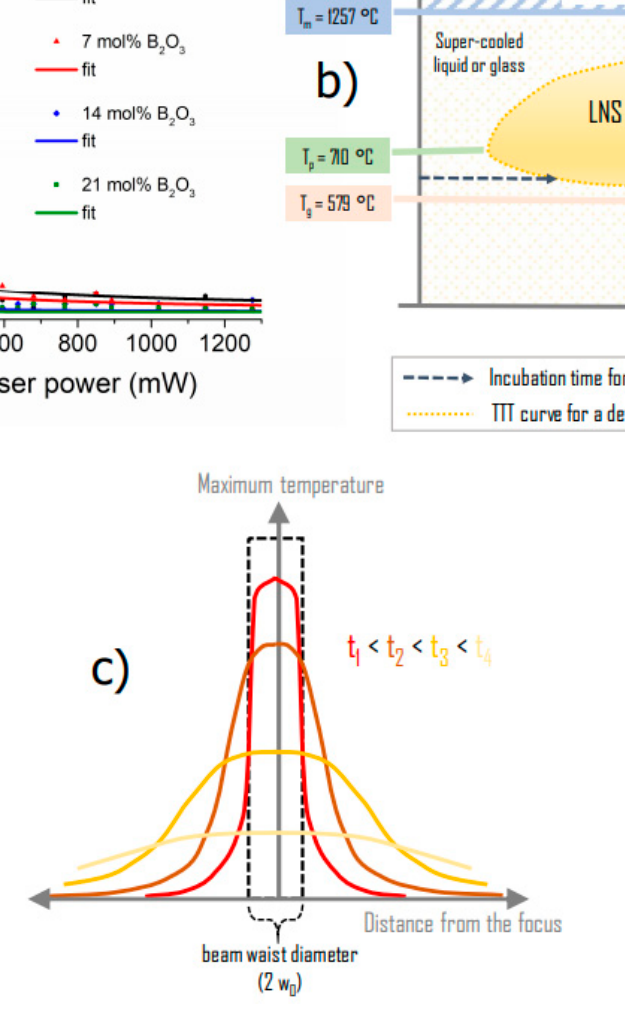
Figure 1. ( a ) Evolution of the incubation time as a function of LNSB glass composition. The results are recalled from [18]. ( b ) Representation of the crystallization domain for LNS glass in TTT (time-temperature-transformation) scheme; T p : crystallization peak temperature, T g : glass transition temperature. ( c ) Scheme of the temperature spatial distribution T(r, t) evolution after pulse deposition inside the glass, and as time evolves. We note that as the maximum temperature decreases with time, the width of the distribution increases (the heat energy in the system remains constant). As a side note, the beam waist radius w 0 is typ. around 1 to 1.5 μ m.